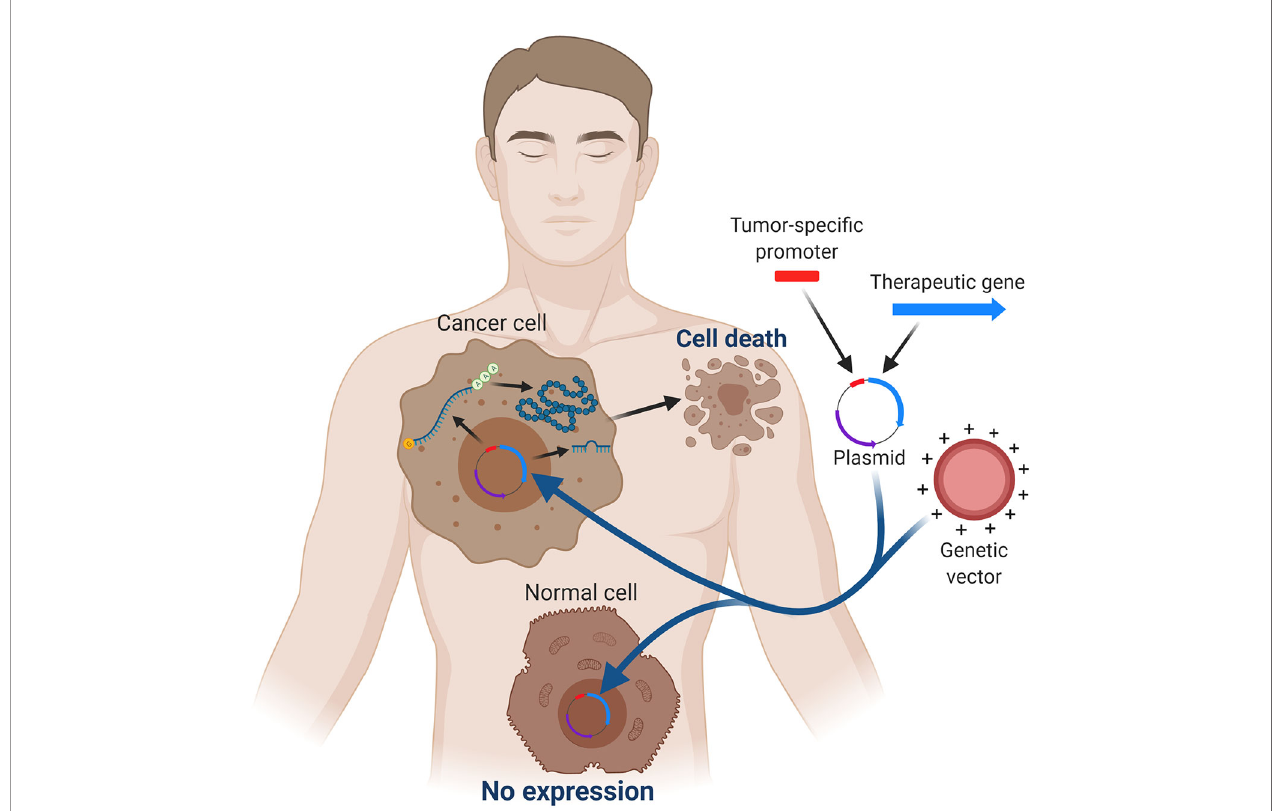
FIGURE 1 | The principle of targeted gene expression controlled by a tumor-speci fi c promoter. Speci fi c transcription factors in cancer cells are able to induce therapeutic gene expression. On the other hand, expression of the therapeutic gene is not obtained in normal cells because they lack the speci fi c transcription factors. Created with